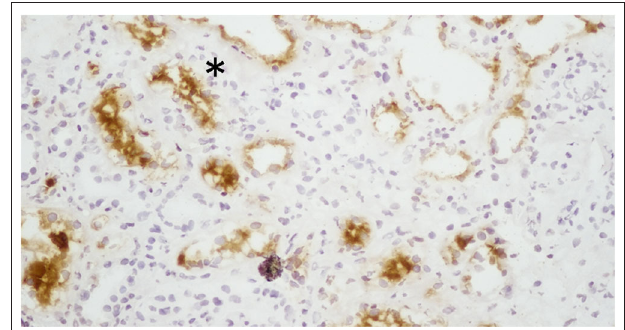
FIGURE 2 | Expression of KIM-1 (kidney injury molecule-1) in the proximal tubules of patients with lupus nephritis. The expression of KIM-1 in this renal biopsy of a patient with LN was stained by immunohistochemistry. KIM-1 was not present in the glomeruli, but it was present in the damaged and dilated tubular cells. *The expression of KIM-1 is observed on the apical surface of proximal tubular cells in the